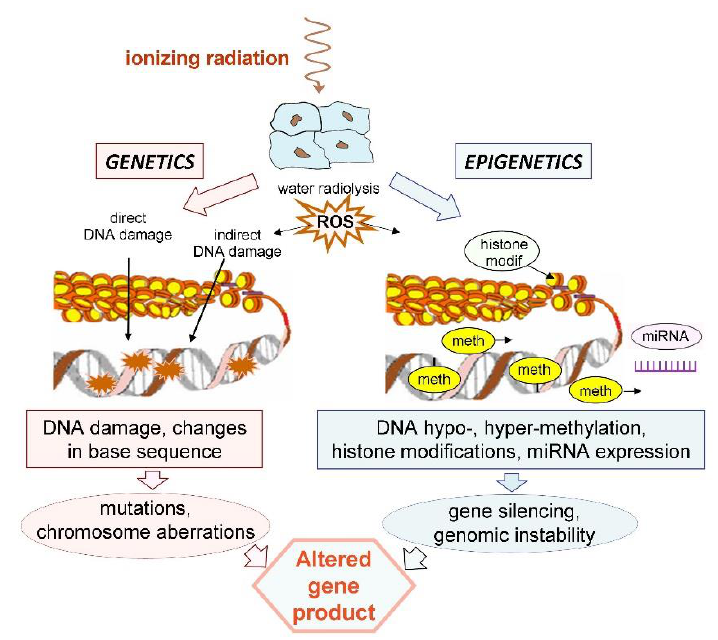
Figure 4. Schematic representation of the cell response to ionizing radiation, where alterations in gene products are due to both genetic and epigenetic mechanisms. These mechanisms share a common pathway originating from ROS production triggered by water radiolysis but, in addition, genetic changes can also be induced by DNA damaged via the direct action of radiation. Unbalanced ROS/RNS production results in oxidative stress with the involvement of mitochondria (not shown here).